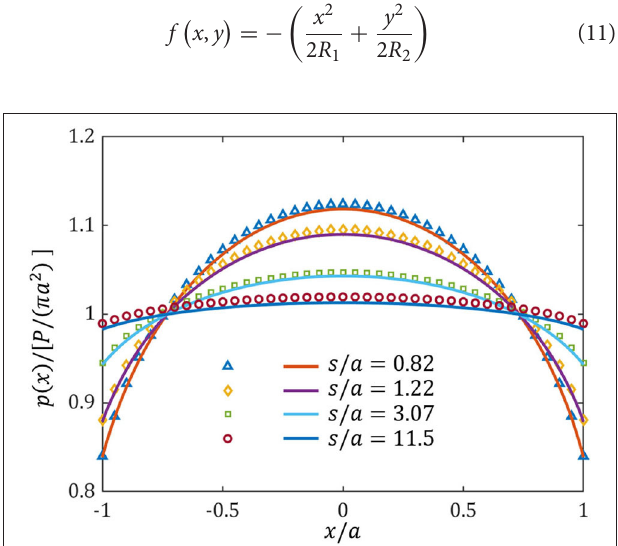
FIGURE 4 | Contact pressure distribution along x -axis direction. Solid lines are the semi-analytical solution from Kim and Gouldstone (2008), and scatter symbols are the numerical results from BEM.